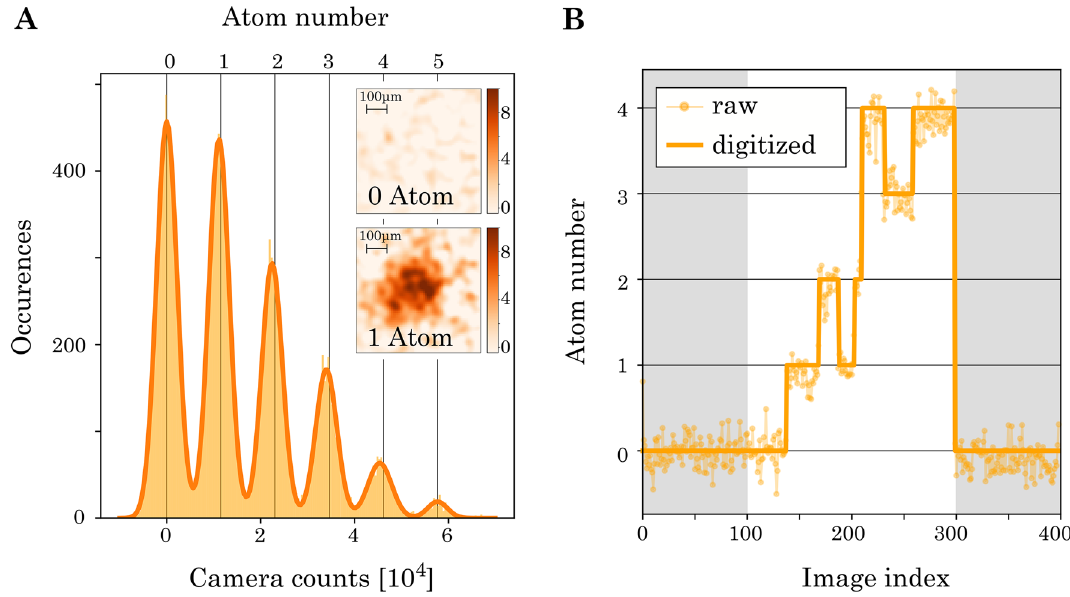
Figure 6. Accurate atom counting of sodium. A: Histogram of recorded camera counts. The calibration from camera counts to atom number is accomplished through Gaussian fits to distinct single atom peaks. Insets show average images of zero and one atom. B: Example time trace before and after